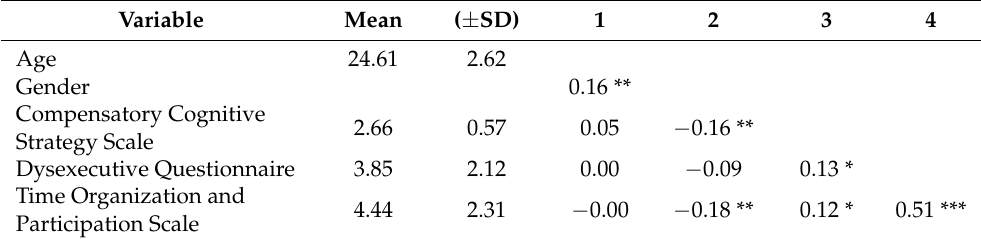
Table 3. Means, standard deviations, and correlations among study